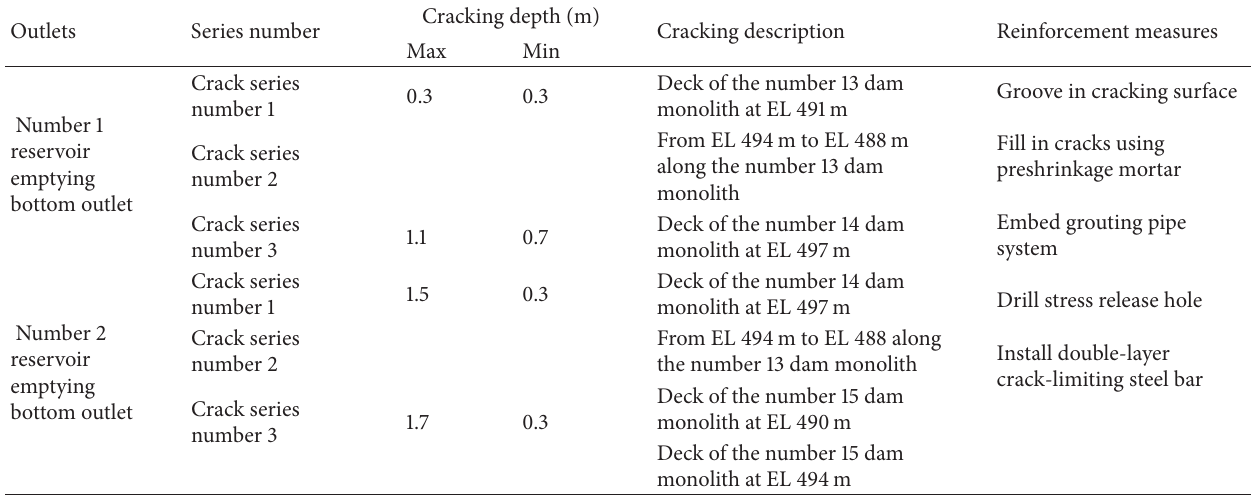
Table 1: Cracking characteristics and reinforcement measures of the numbers 1 and 2 reservoir emptying outlets in the Goupitan arch